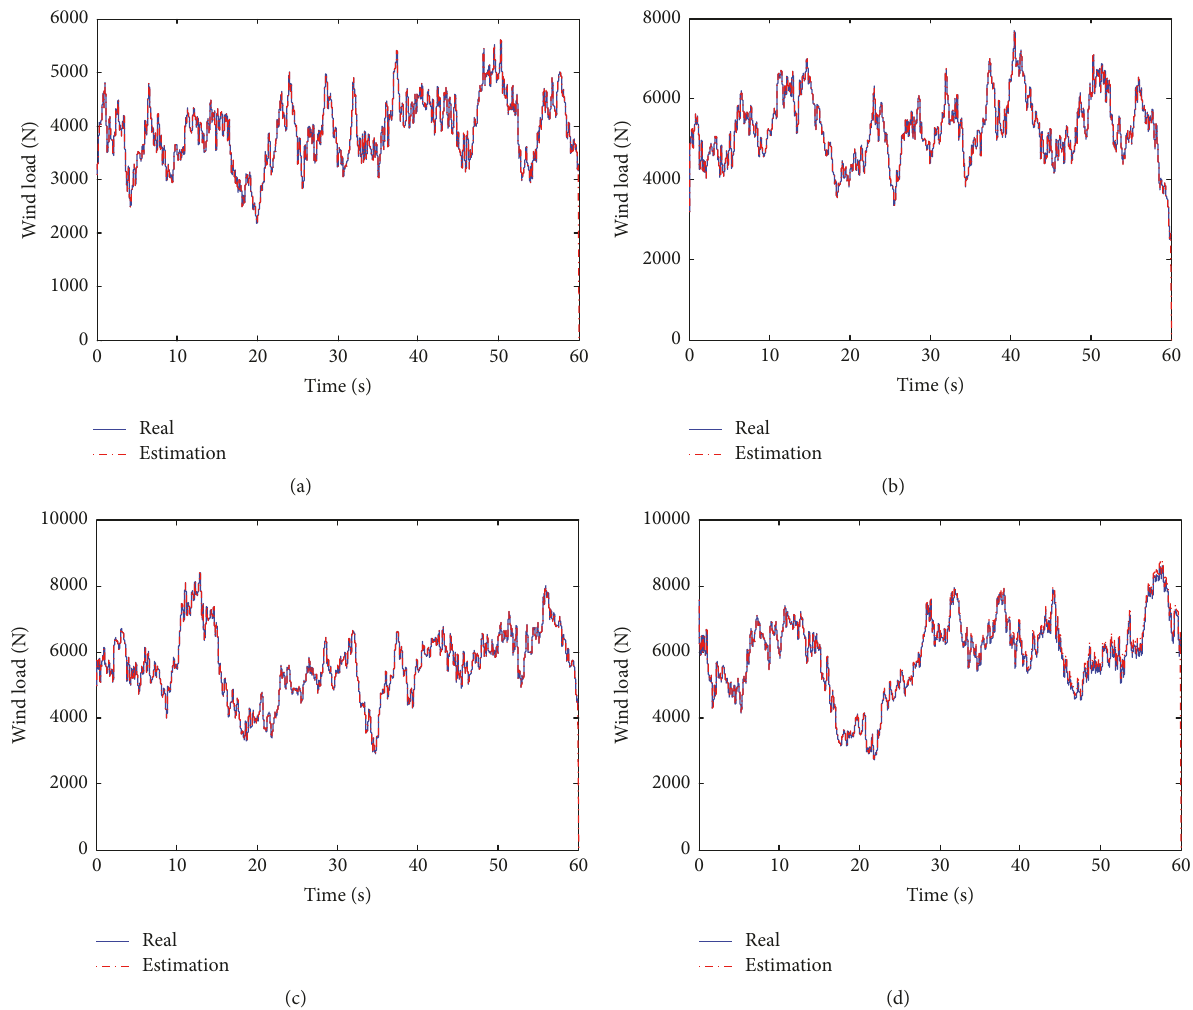
Figure 5: Comparison of time-varying wind load on the building. (a) On the 5th floor; (b) on the 10th floor; (c) on the 15th floor; (d) on the 20th